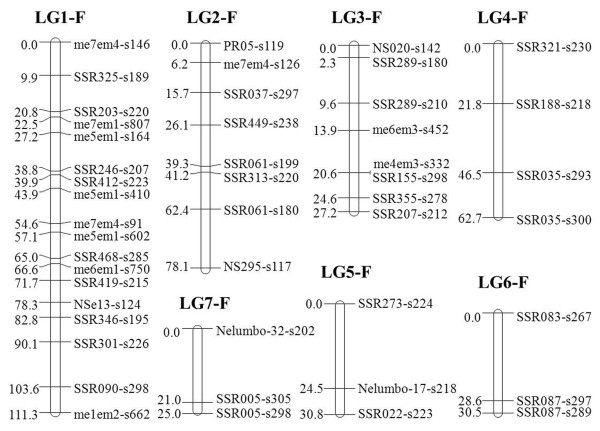
Genetic linkage map of Asian lotus (Nelumbo nucifera) constructed with SSR and SRAP markers. Map distances in centi-Morgans (cM) and marker names are shown on the left and right sides of each linkage group (LG1-F to LG7-F), respectively. The marker nomenclature corresponds to the primer name followed by “s” (abbreviation of “size”) and the size of product (in base pair).